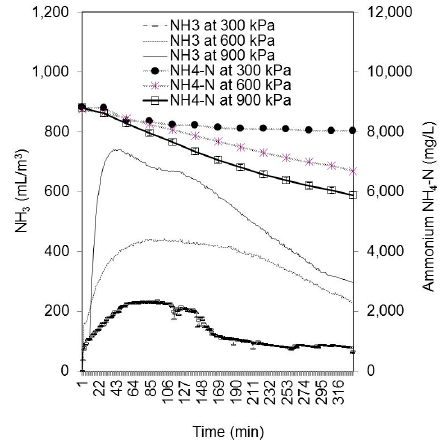
Figure 4. Ammonia stripping process: quantities of NH 3 ( μ L/L) in the exhaust air (lines) and quantity of NH 4 -N (mg/L) in the DSW mixture (lines with marks). The ammonia gas (NH 3 ) concentration in the exhausted air raised fast in the first hour after pressure increase, and later slowly declined. The ammonium nitrogen (NH 4 -N) content of the DSW linearly declined over 334 min of the process. Energies 2018 , 11 , x FOR PEER REVIEW